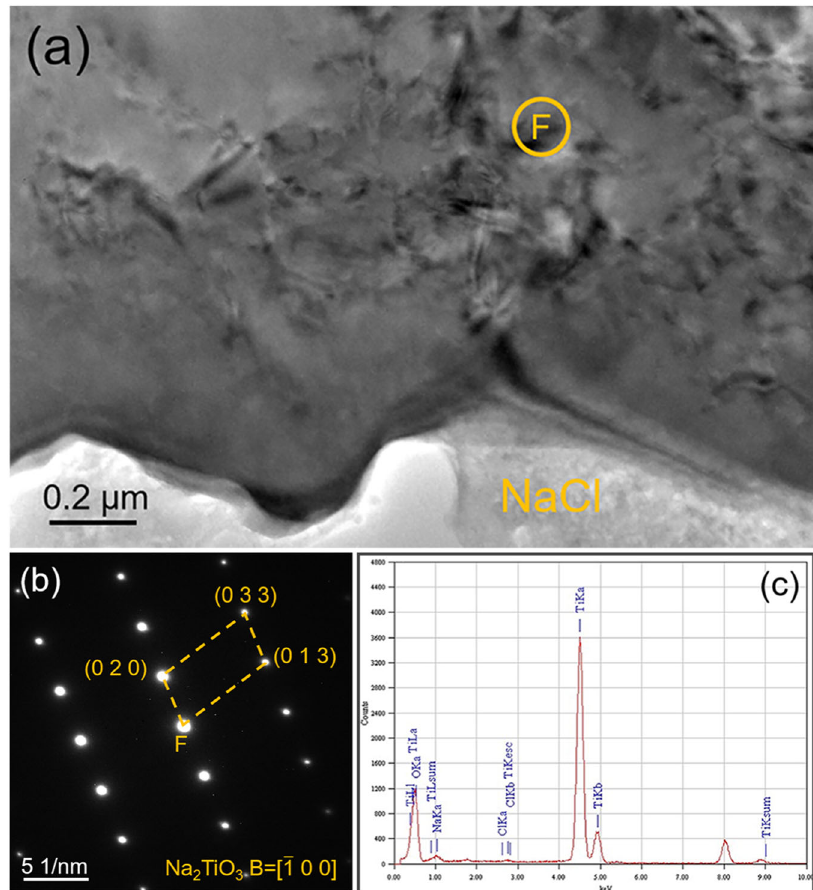
Fig. 6 Outer layer TEM results of pure Ti after corrosion in continuous NaCl solution spraying for 5 h at 600 °C. a TEM image, b SAED patterns of area F, and c the EDS spectra of area